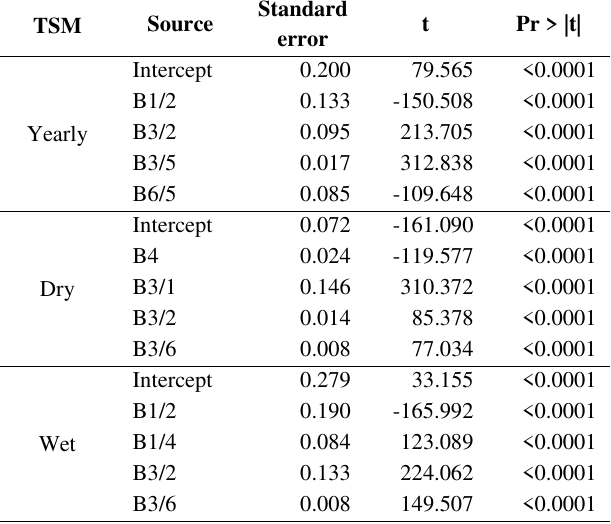
Table 7. Model parameters for the TSM models.